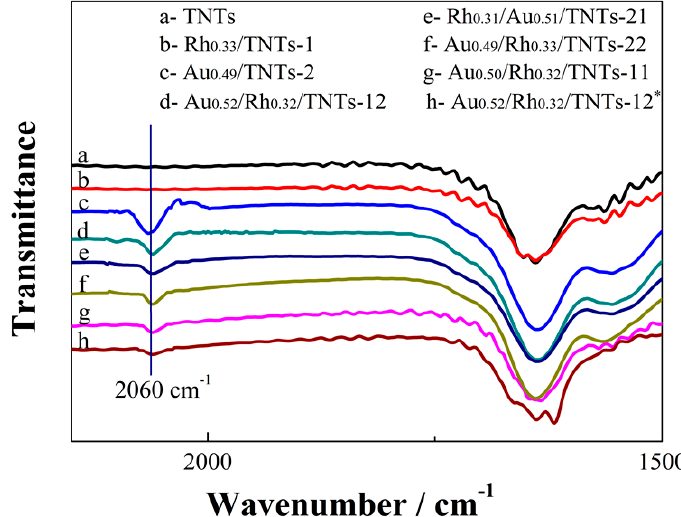
Figure 5. CO-FT-IR patterns of samples. Figure 5. CO ‐ FT ‐ IR patterns of samples. Figure 5. CO ‐ FT ‐ IR patterns of samples.